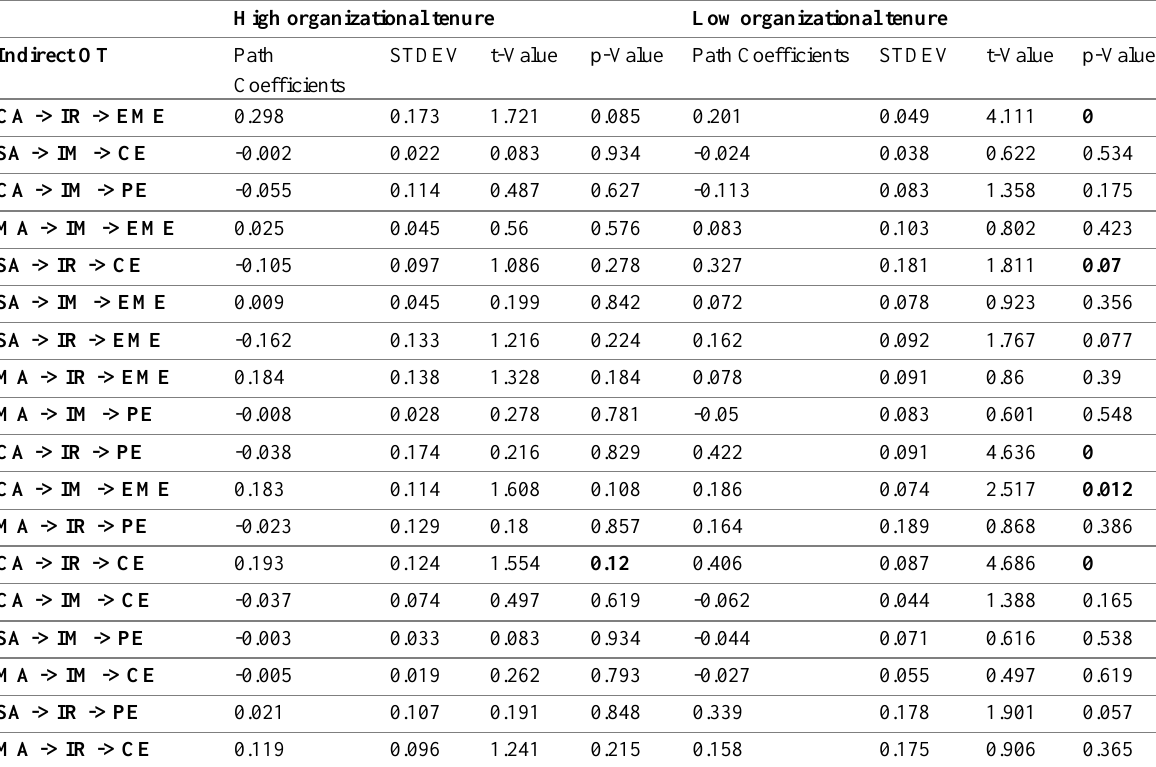
Table 12: Multi-group analysis for organizational tenure (indirect